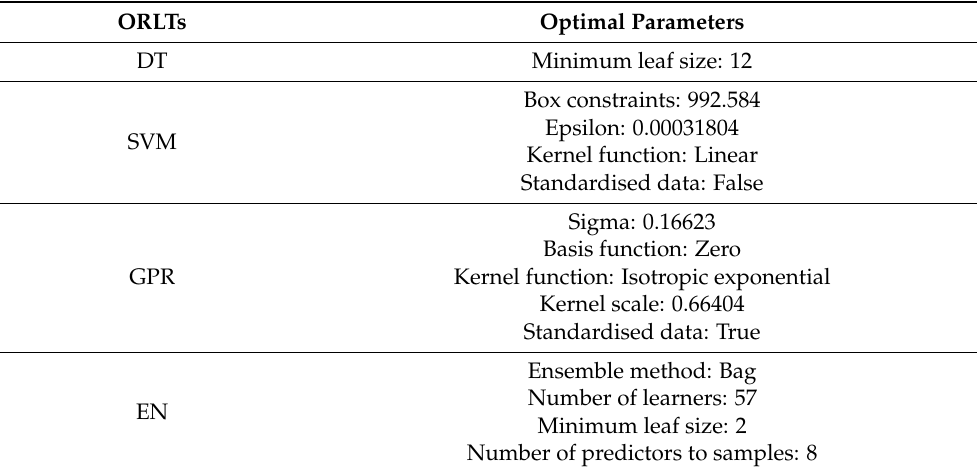
Figure 7. ( a ) Minimum MSE vs. iteration number; ( b ) predicted response vs. true response during training. Table 2. Optimal parameters of each ORLT.